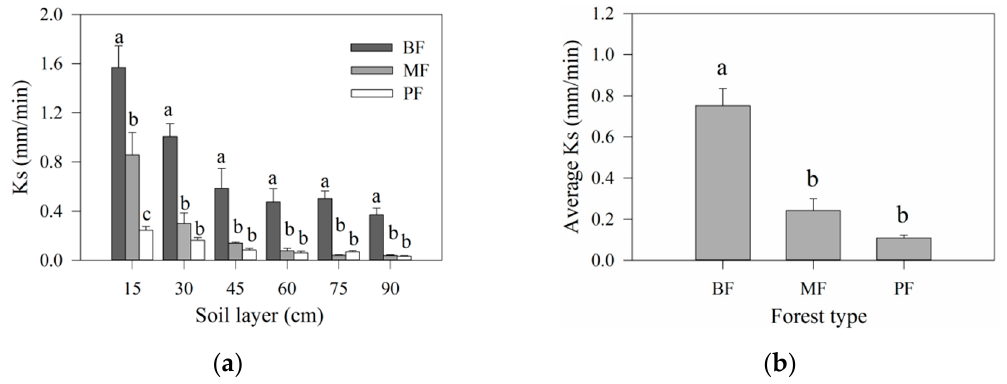
Figure 6. Distribution of K S along the soil profile ( a ) and the differences in average K S in the different forests ( b ) in Dinghushan. Values are the means ± SE. Lowercase letters above the columns represent statistically significant differences among stand types (Duncan’s test, p < 0.05). Abbreviations: K S , saturated hydraulic conductivity; PF, Pinus massoniana forest; MF, mixed Pinus massoniana /broad-leaved forest; BF, monsoon evergreen broad-leaved forest.